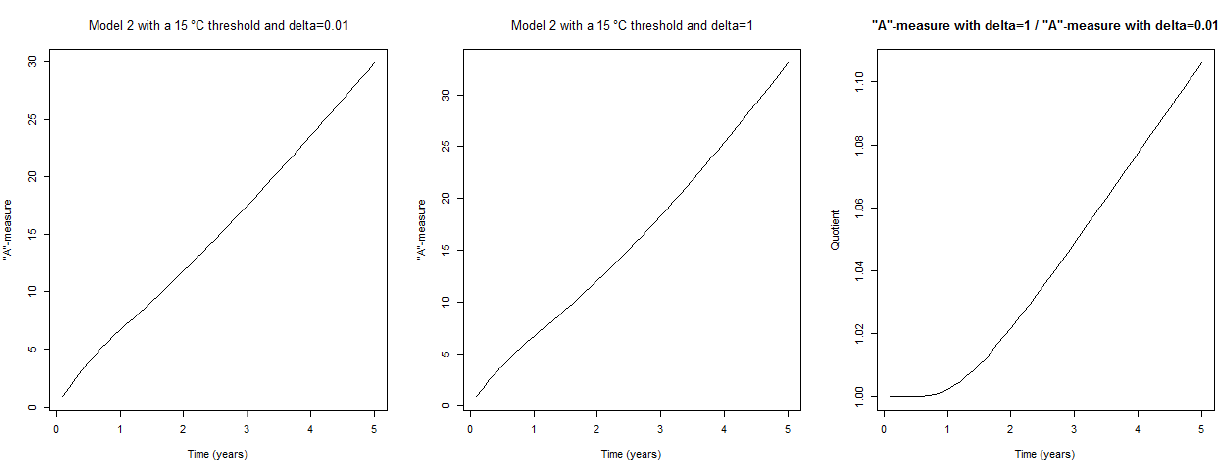
Figure 4. A-measure for Model 2 Equation (11) with new volatility Equation (12) with δ = 0 . 01 and δ = 1 , initial temperature equal to 24 ◦ C and threshold equal to 15 ◦ C. A-measure is plotted as a function of time of maturity (from zero to five years). The right-hand side graph is the quotient between the two others